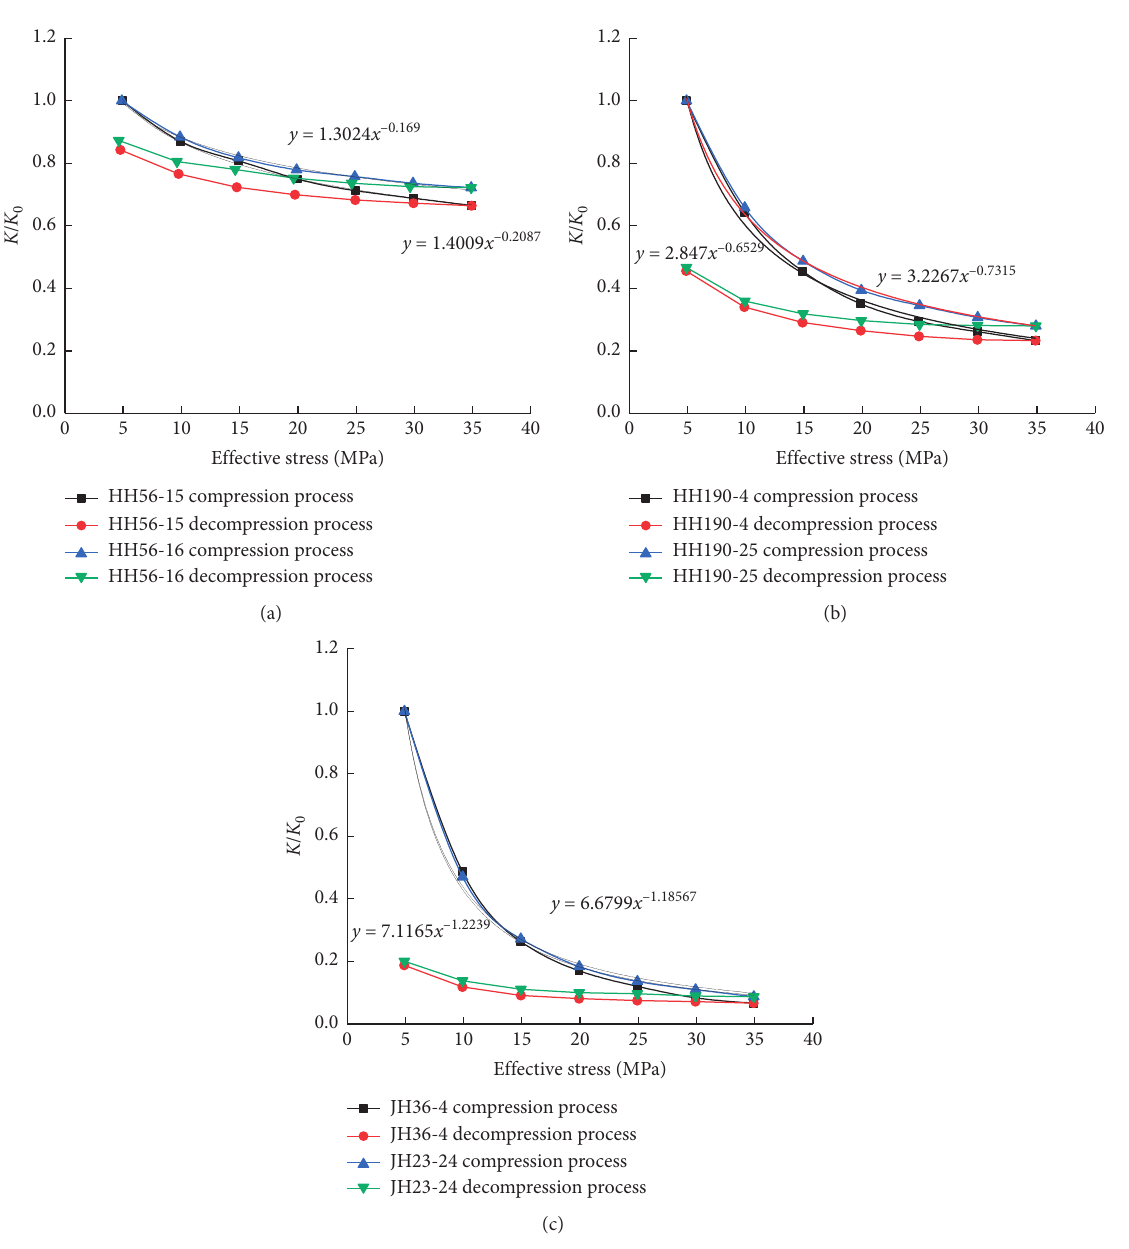
Figure 5: Permeability retention rate of cores at different effective